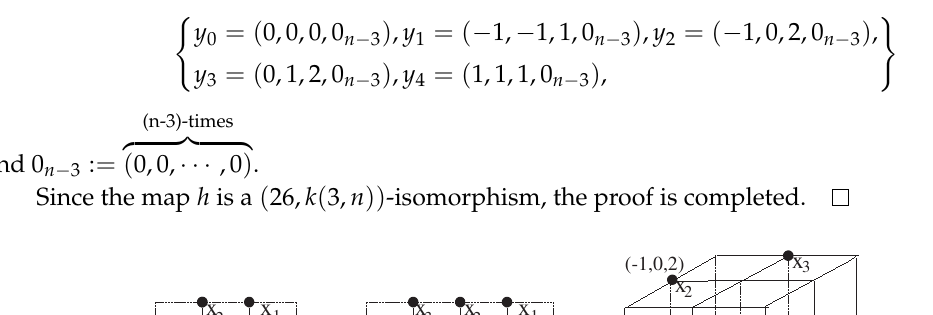
Figure 1. Configuration of several types of SC n , l